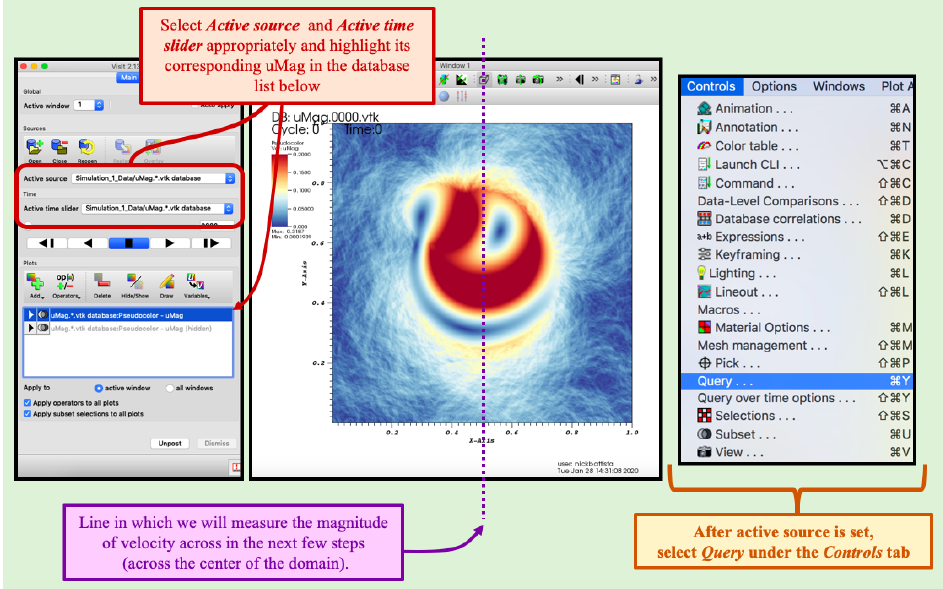
Figure 16. To analyze data in VisIt, the active source and active time slider must be set to specific data that is desired to be analyzed, e.g., here it is the magnitude of velocity, uMag , for the Simulation_1_Data